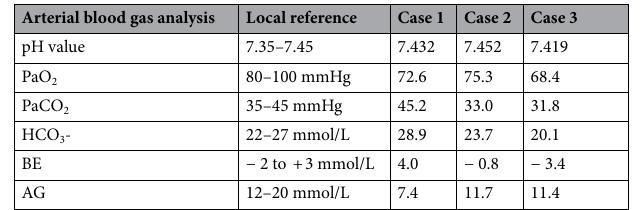
Table 2. Arterial blood gas analysis. PaO 2 , arterial partial pressure of oxygen; PaCO 2 , arterial partial pressure of carbon dioxide; BE, base excess; AG, anion gap.